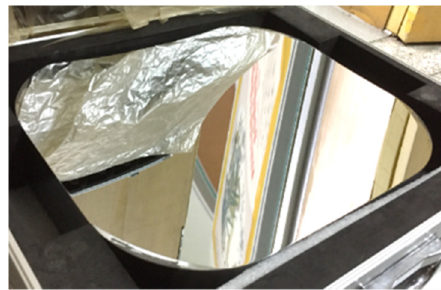
Fig. 4. The finished mirror surface. (Primary mirror)